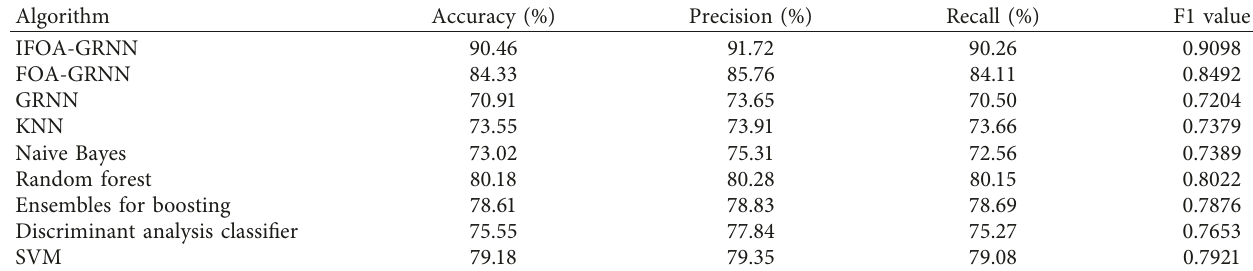
Figure 8: FOA-GRNN convergence graph. Table 5: Prediction effect table of different